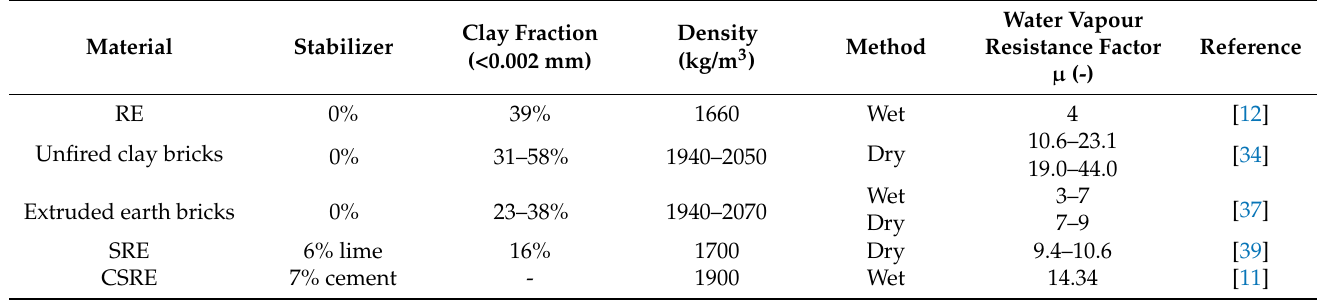
Table 1. Water vapour resistance factor of earthen